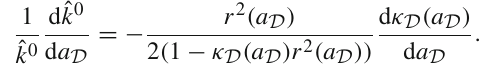
( a ), the red- 0 = 70 km s − 1 Mpc − 1 0